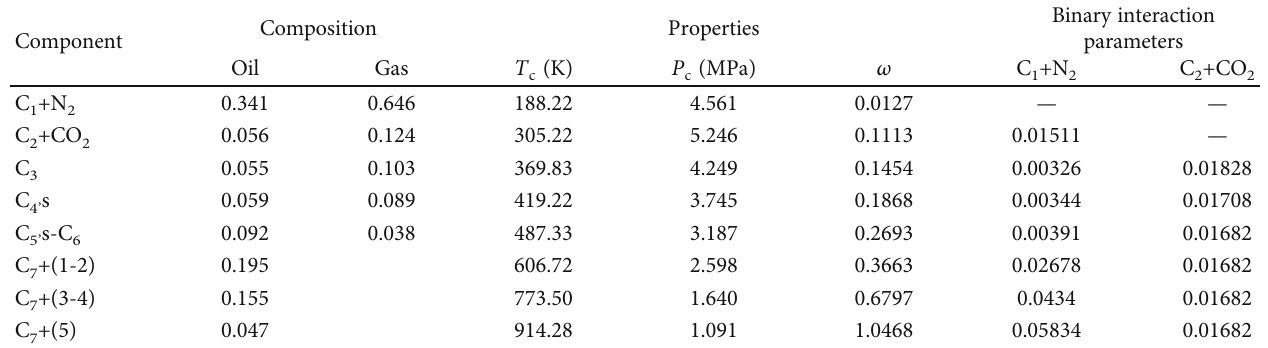
Table 2: Oil and gas compositions and PR-EOS properties for Case 3 [19, 33]. Component